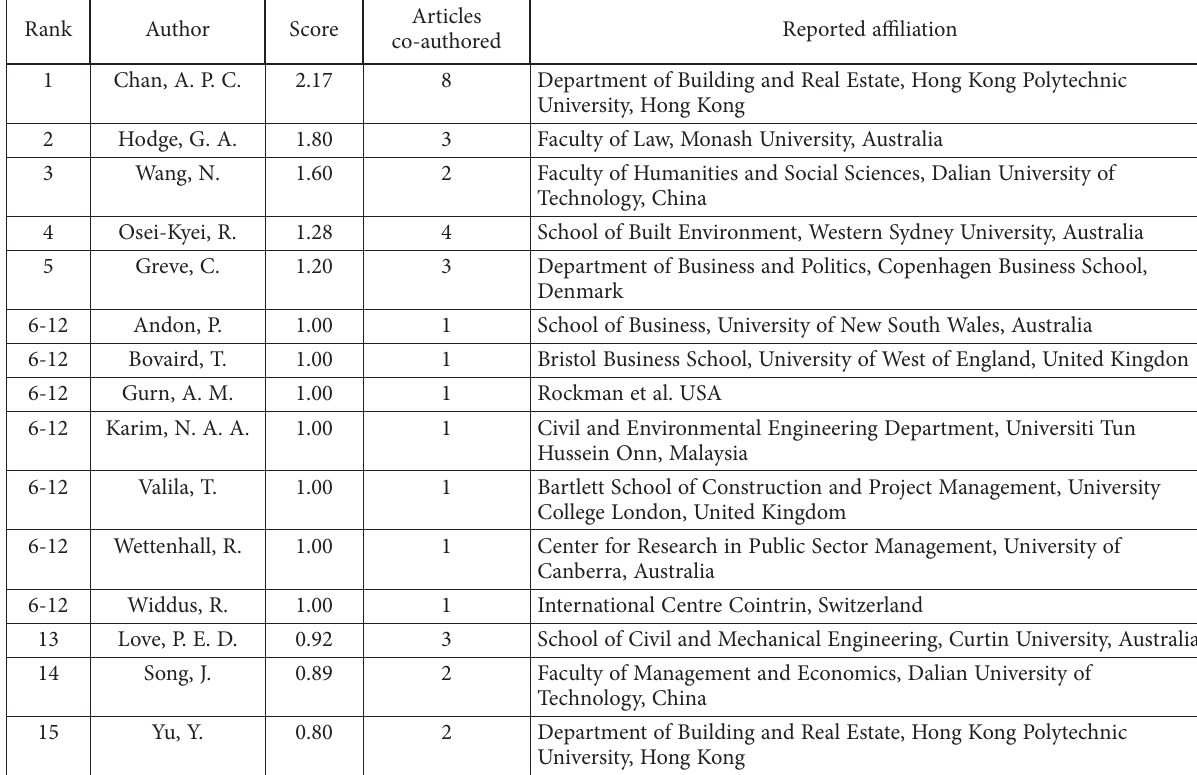
Table A2. Top 10% most productive authors in the PPP review